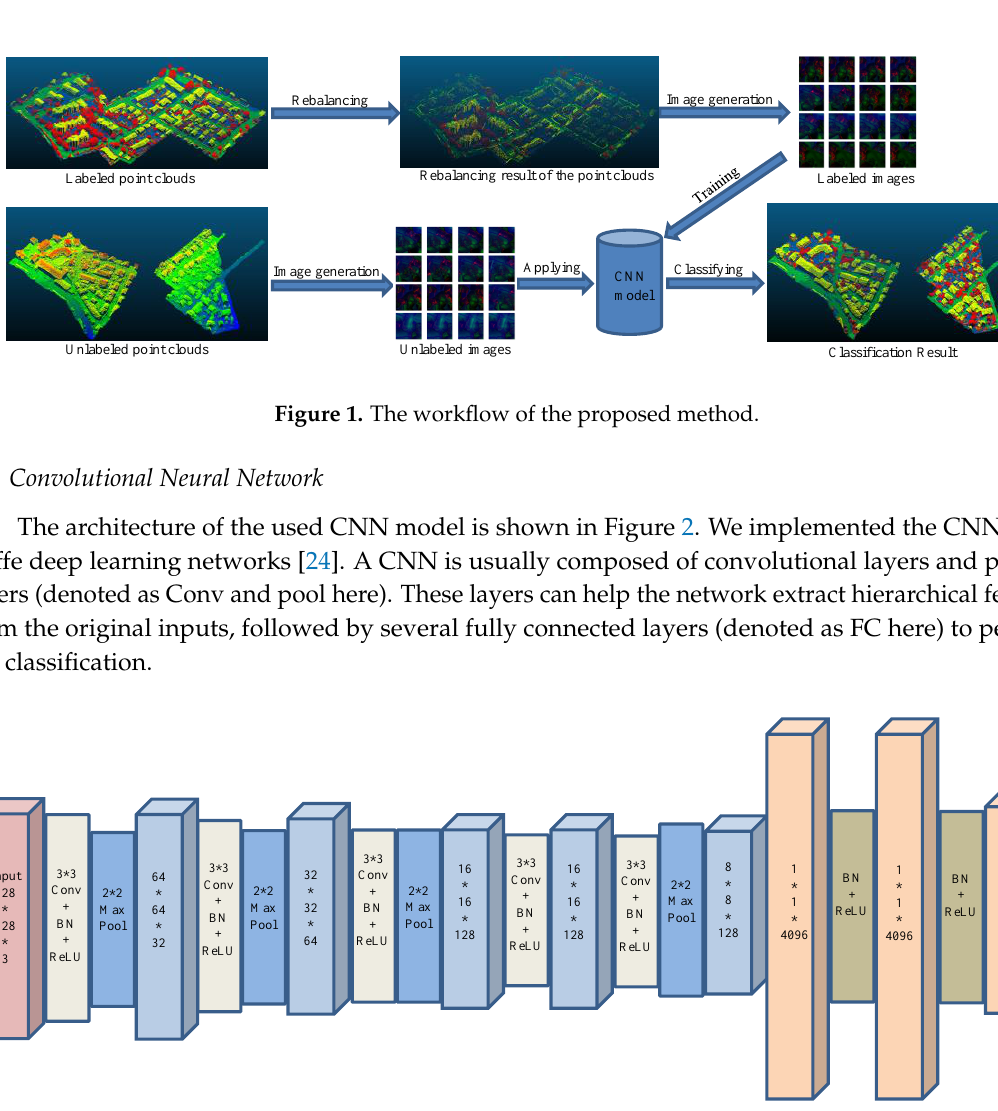
Figure 2. The architecture of the deep CNN used.